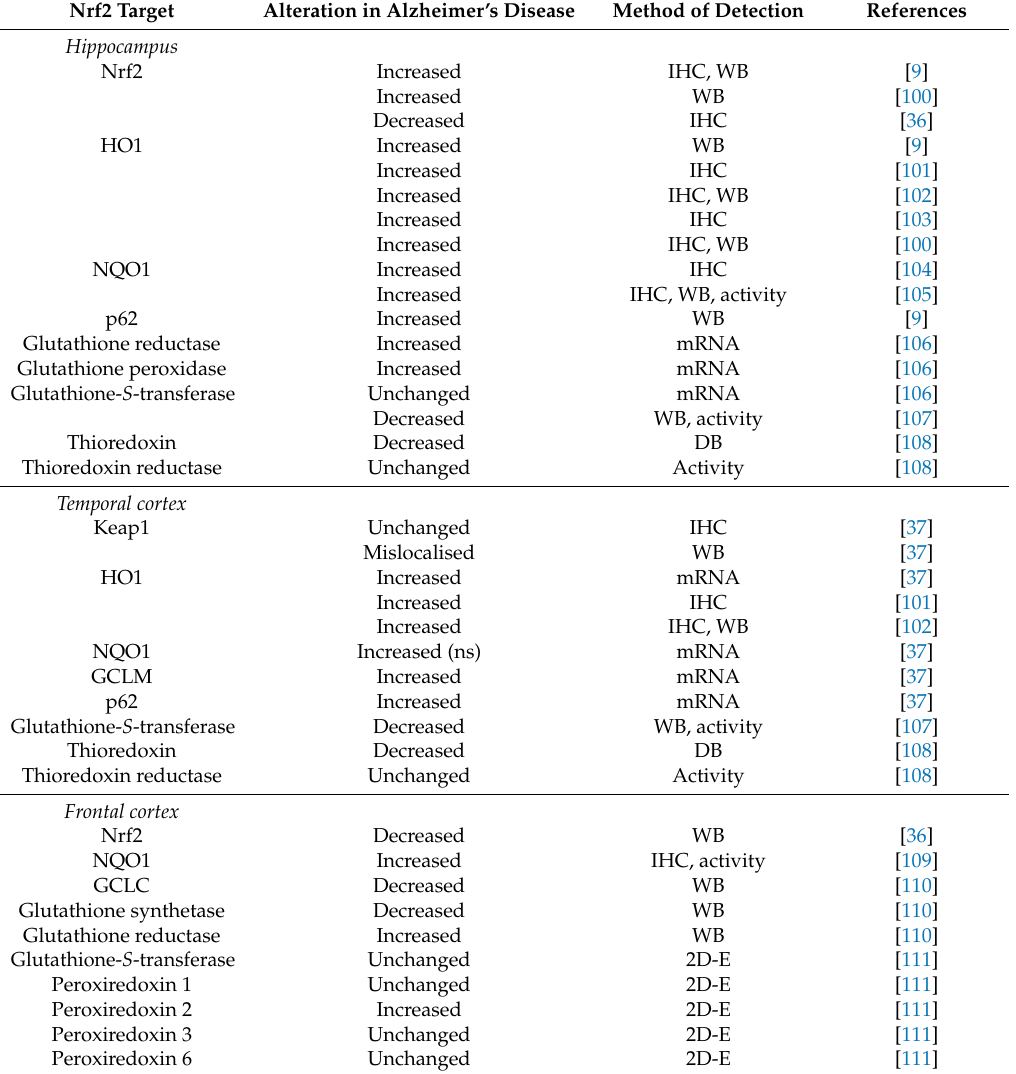
Table 3. Alterations in Nrf2 and Nrf2 targets in post-mortem Alzheimer’s disease brain